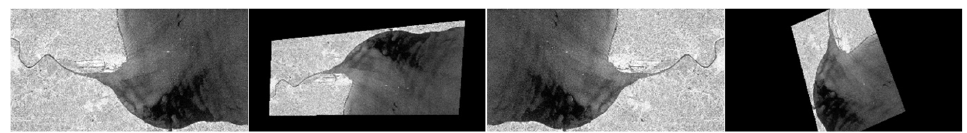
Figure 1. Different augmentations applied to the same image. From left to right: original image; image perspective with horizontal flip composition; vertical flip augmentation only; horizontal, vertical, and image rotation combined.